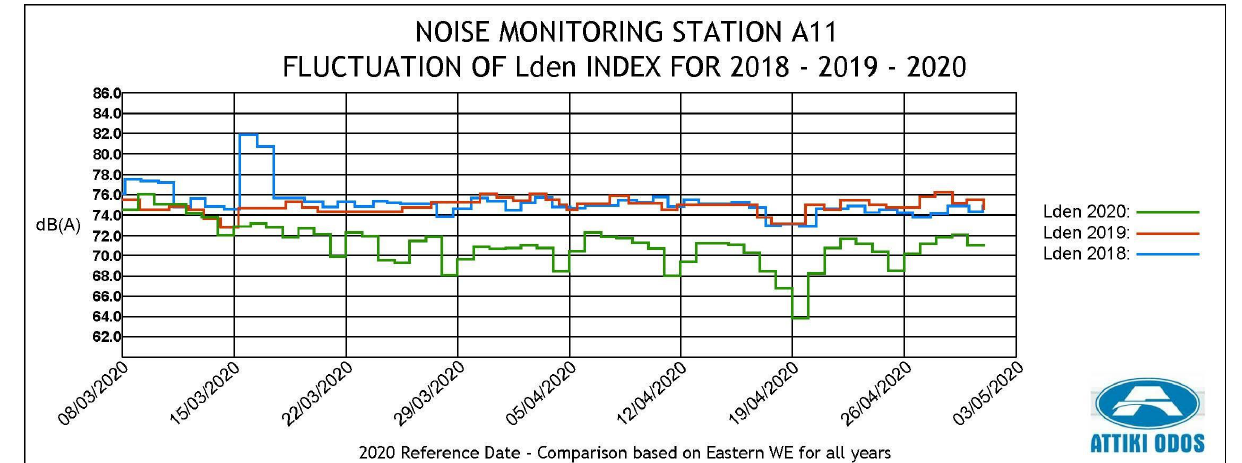
Figure 9e: Fluctuation of L den index – Noise monitoring station A11